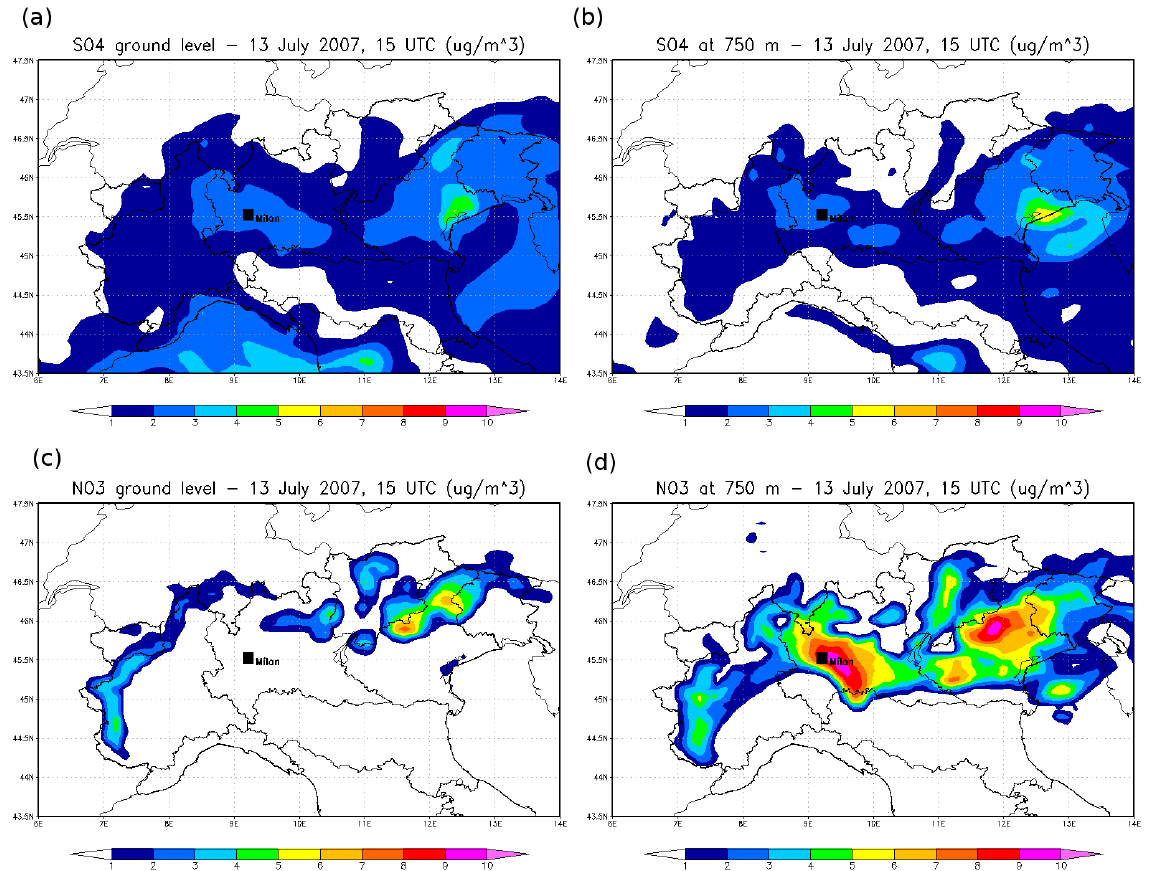
Figure 8. Maps of the concentration of PM 2 . 5 sulfate (a, b) and nitrate (c, d) components simulated at 16:00LST on 13 July 2007 over the Po Valley. Panels (a–c) show ground-level concentrations (the first model level is about 24m thick); panels (b–d) show concentrations at approximately 750m.